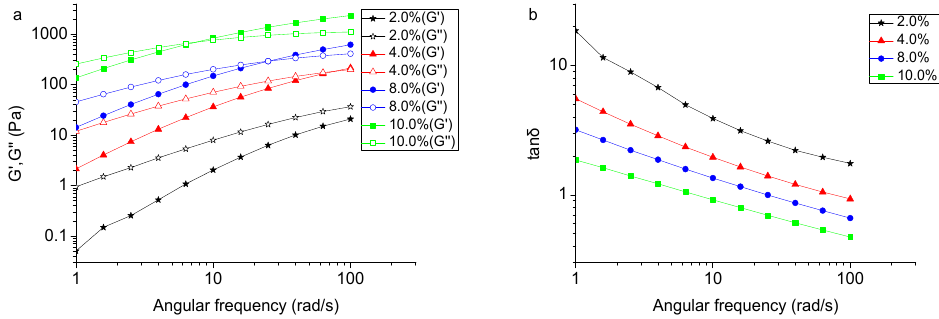
Figure 4. ( a ) Angular frequency dependencies of shear modulus G’(storage) and G’’(loss) of TSP at different concentrations at 25 °C; ( b ) Angular frequency dependency of tan δ of TSP at different concentrations at 25 °C.